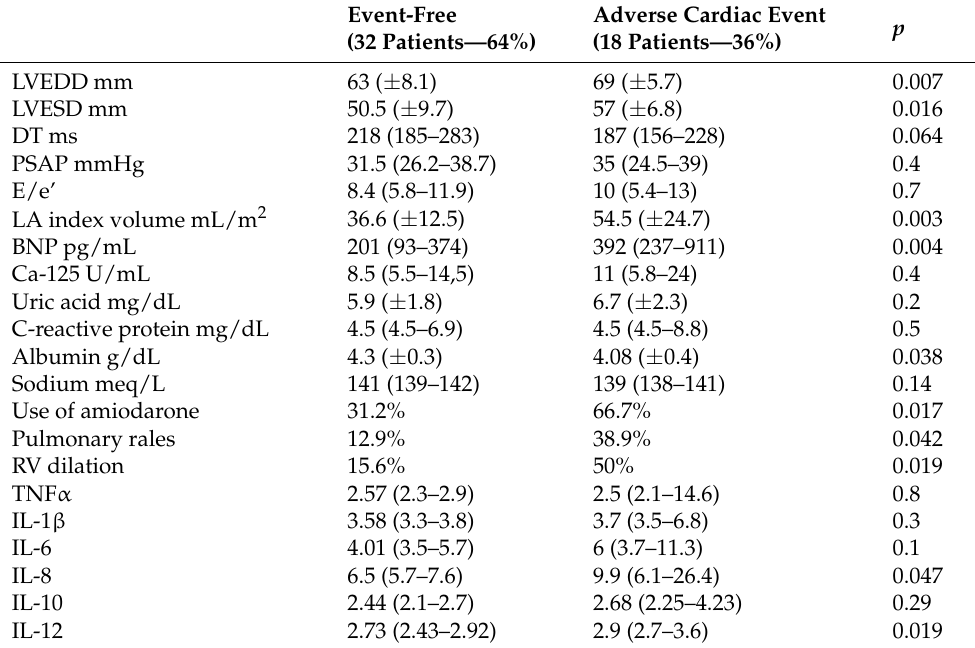
Table 2. Echocardiography, laboratorial and clinical parameters and adverse cardiac